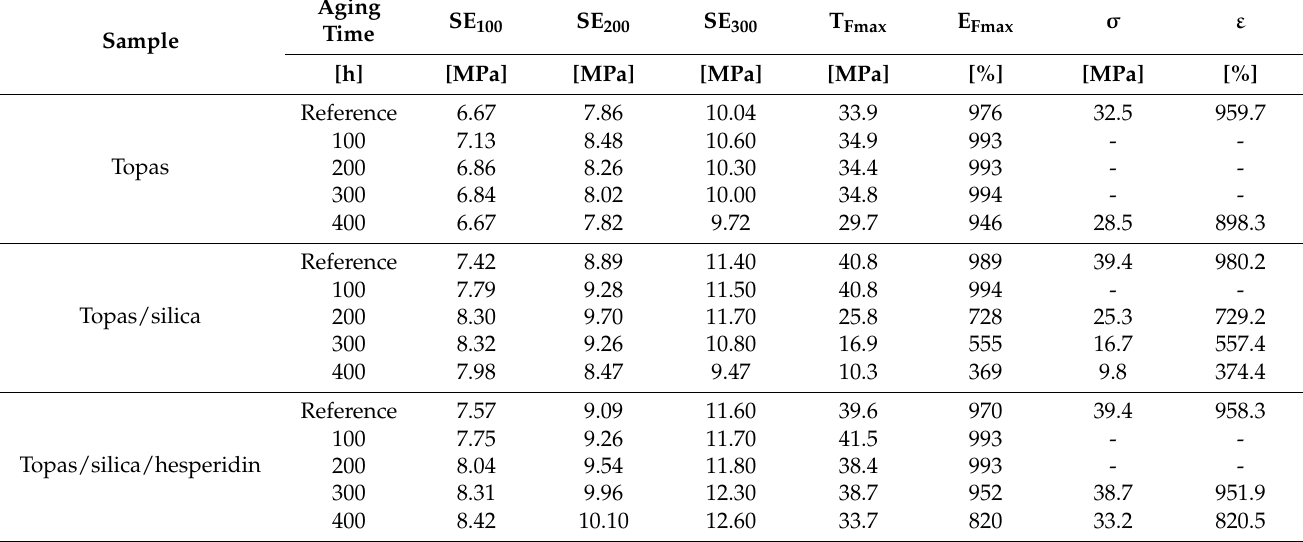
Table 3. Mechanical properties of samples based on ethylene-norbornene copolymer before and after weathering, where SE 100,200,300 are the stresses at 100, 200, and 300% of elongation, respectively, T Fmax is the maximum stress transferred by the sample [MPa], E Fmax is the elongation at break for the maximum tensile stress [%], σ is a tensile strength [MPa], and ε is a total elongation at break